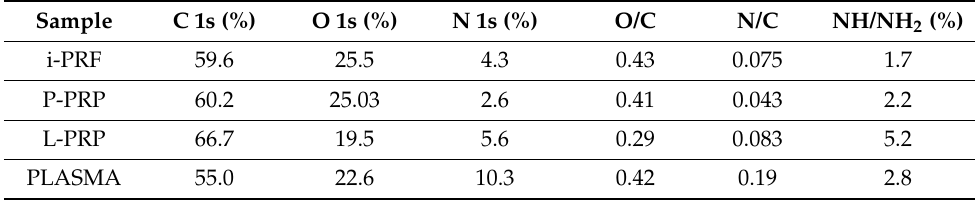
Table 1. Summary of the C, O and N proportions as obtained by